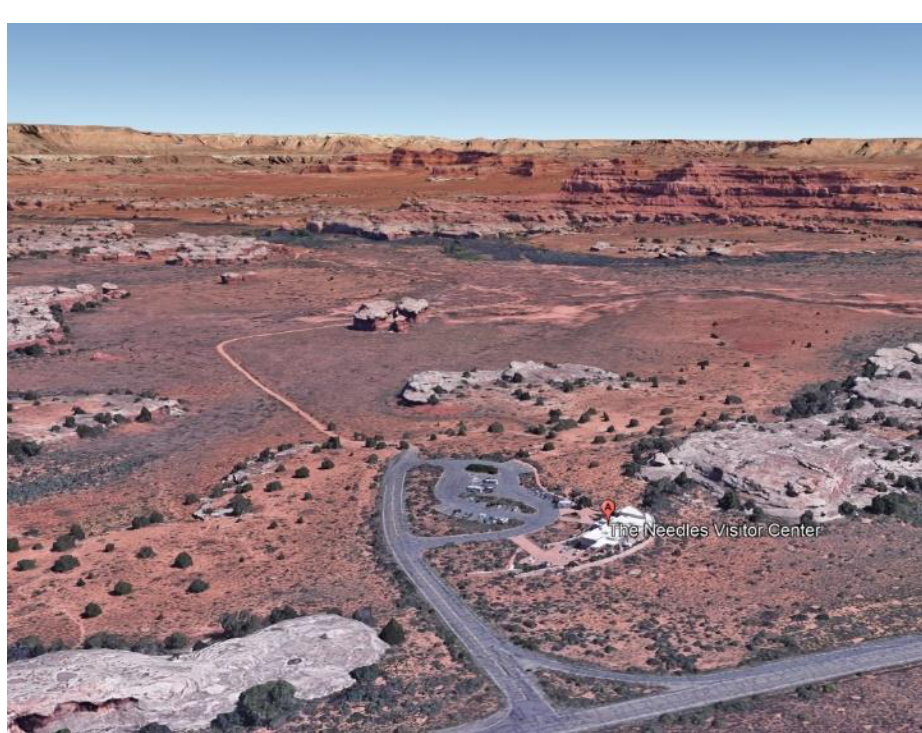
Figure 12. The Needles visitor centre (from Google Earth Pro V 7.3.4 (5 May 2022), 38°10′05.69″N, 109°45′34.13″W, Eye alt 1.78 km, Landsat, Copernicus, Maxar Technologies/USDA/FPAC/GEO 2022, [46]).